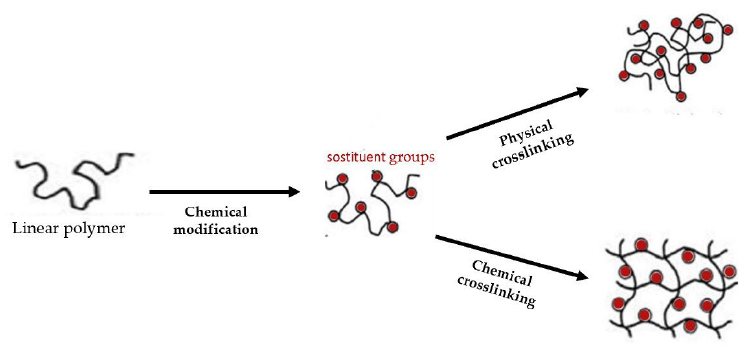
Figure 2. Scheme of chemical and physical hydrogel formation from a linear polymer.